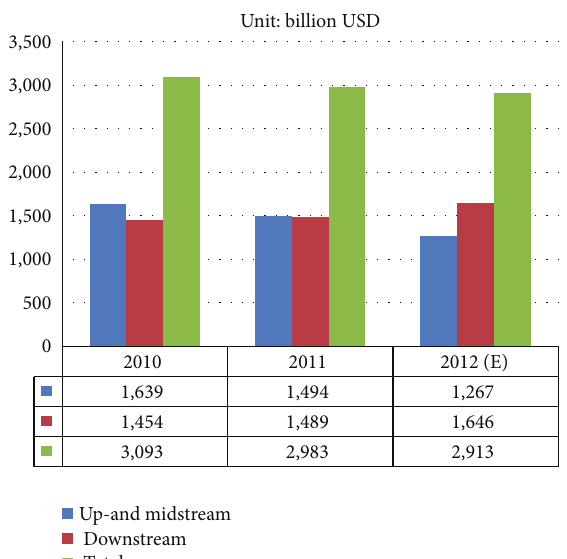
Figure 3: 2012 revenue of global LED industry. Source: Topology Research Institute (2012) [1]. Up- and midstream: Epi-wafer and grain. Downstream: package and